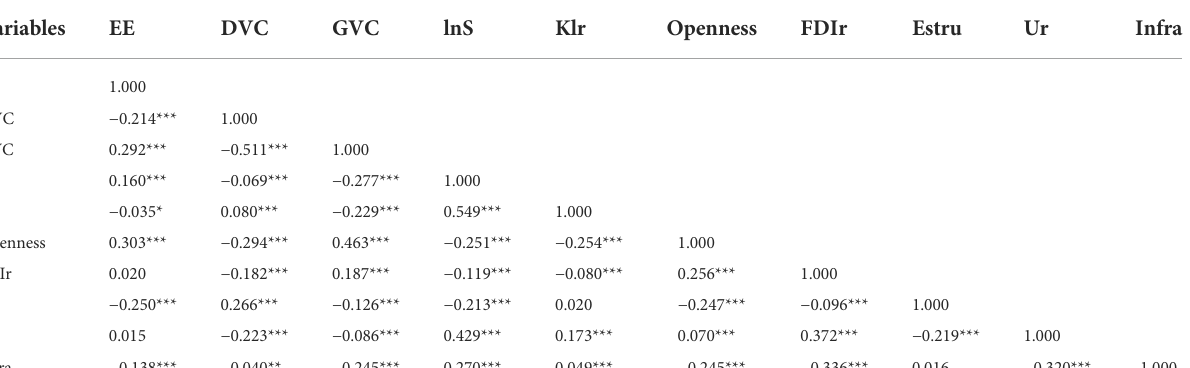
TABLE 2 Correlation